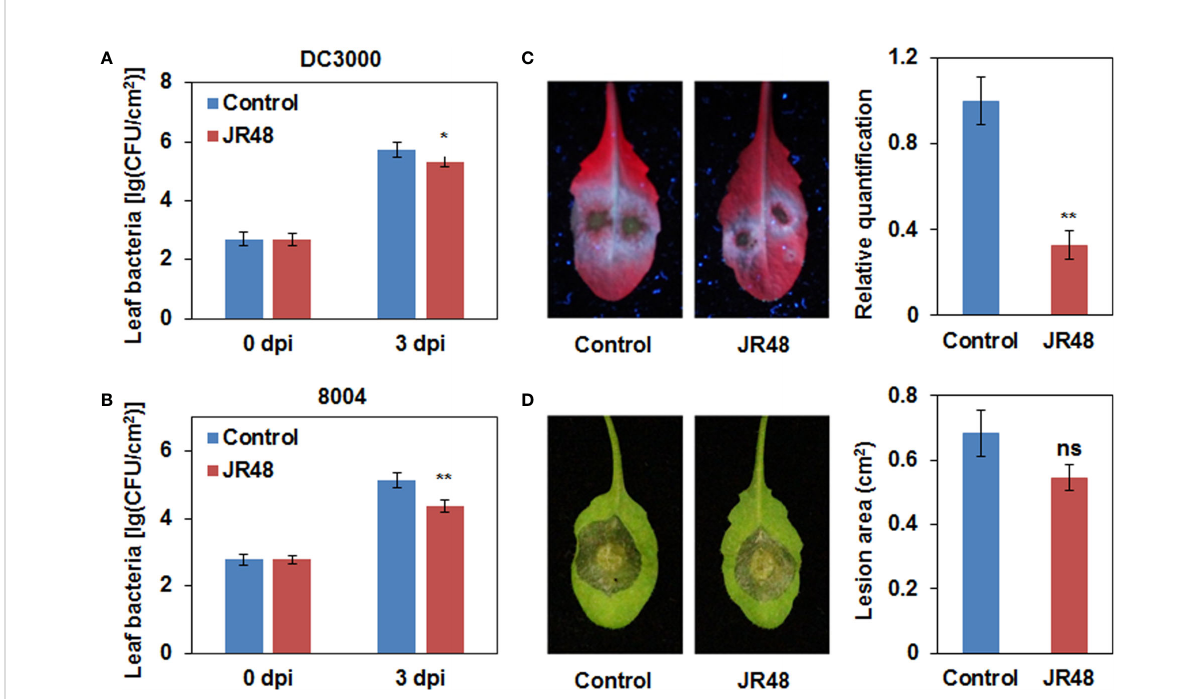
FIGURE 3 Enhanced plant resistance by JR48. (A,B) Bacterial population in Arabidopsis leaves. Pst DC3000 (A) and Xcc 8004 (B) were in fi ltrated into leaves of wild-type Arabidopsis Col-0 pre-treated with sterile water (control) or JR48. Bacterial population was measured at the indicated time points (mean ± SD; n (number of leaves) ≥ 6; *P < 0.05 and **P < 0.01, Student ’ s t -test). Experiments were repeated in triplicate. (C) P. capsici inoculation on Arabidopsis . Zoospore suspensions of LT263 were dripped on leaves of Col-0 pre-treated with control or JR48. Infected leaves were photographed under UV light. The relative biomass of P. capsici was measured by qRT-PCR. Data presented are means ± SD (n ≥ 16), ** indicates signi fi cant differences (P < 0.01, Student ’ s t -test). This experiment was repeated at least three times with similar results. (D) B. cinerea inoculation on Arabidopsis . Mycelial plugs of B05.10 were inoculated on leaves of Col-0 pre-treated with control or JR48. Inoculated leaves were photographed under natural light at and lesion area was measured. Values are presented as means ± SD (n ≥ 16) calculated from three independent biological replicates (ns, not signi fi cant, Student ’ s t